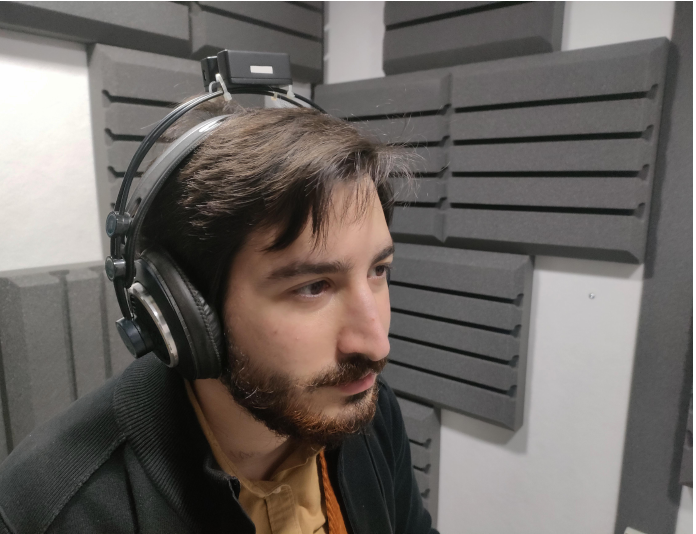
Figure 10. Motion-tracking headphones. By controlling the individual HRTF structural model, it allows perceiving the position of the virtual sound source independent of head